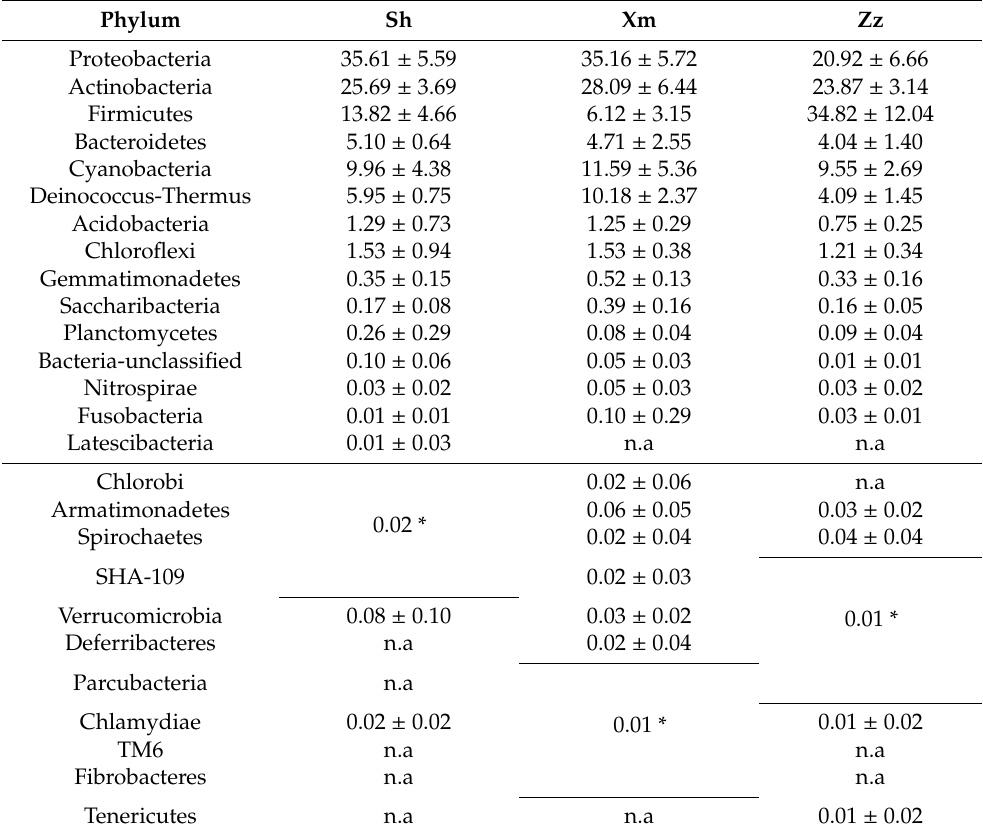
Table 1. Relative abundances (average with one standard deviation) of phylum in three